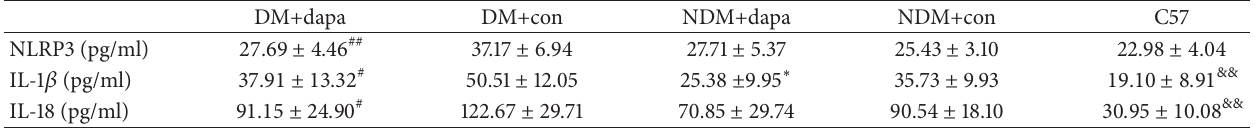
Table 2: The concentration of serum NLRP3, IL-1 𝛽 , and IL-18 in each group.